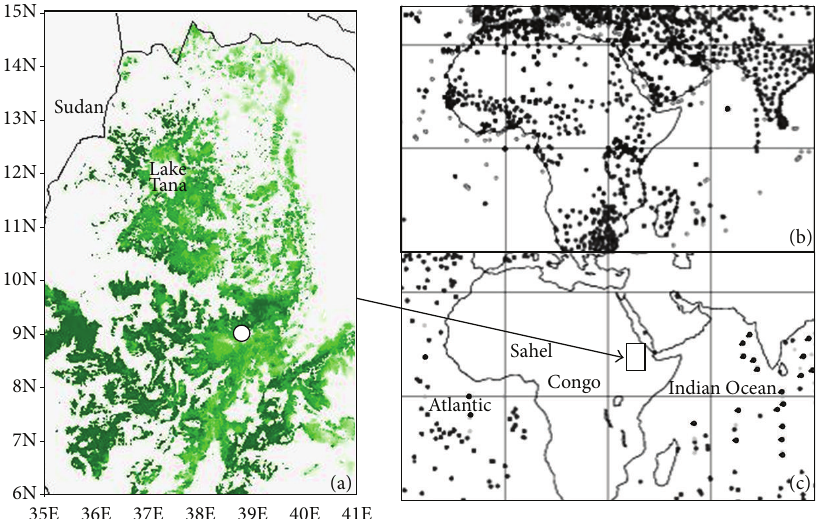
Figure 1: (a) Ethiopian crop cultivation areas (shaded green) and (b) station/ship and (c) buoy/drifter observations. Capital city (dot) and Lake Tana shown in (a); place names and box for model evaluation in (c).